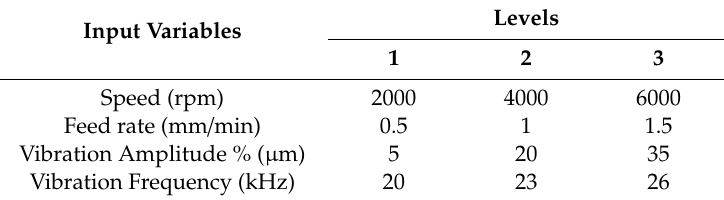
Table 3. Input variable and their levels.